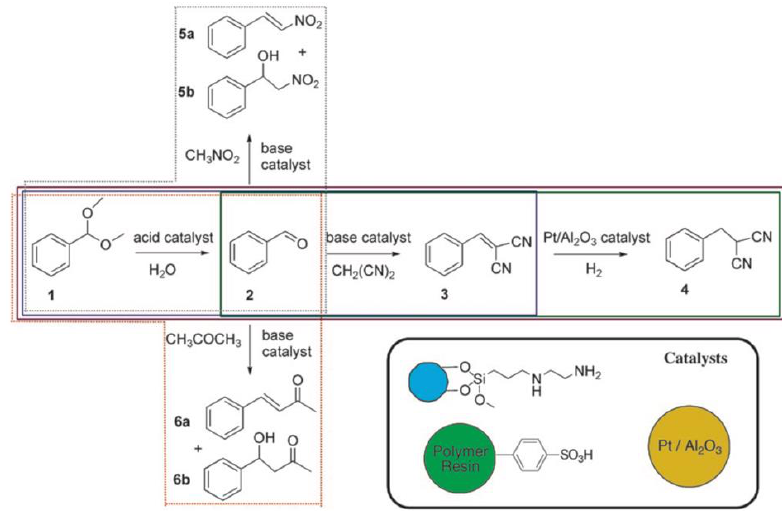
Figure 3. Multistep cascade reaction mediated by a combination of three different supported catalysts in a one-pot reaction. Each colored box shows a different reaction path. Reproduced with permission of [50]. Copyright 2006 Wiley-VCH.